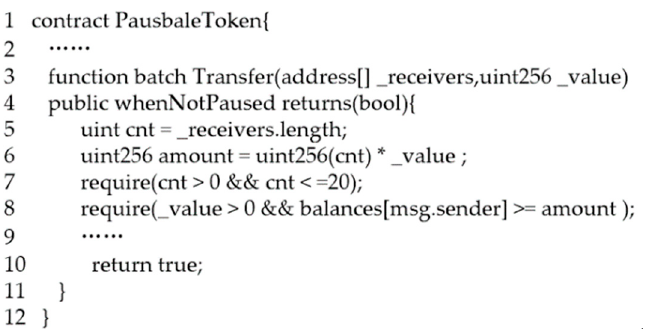
Figure 1. Integer overflow vulnerability case.